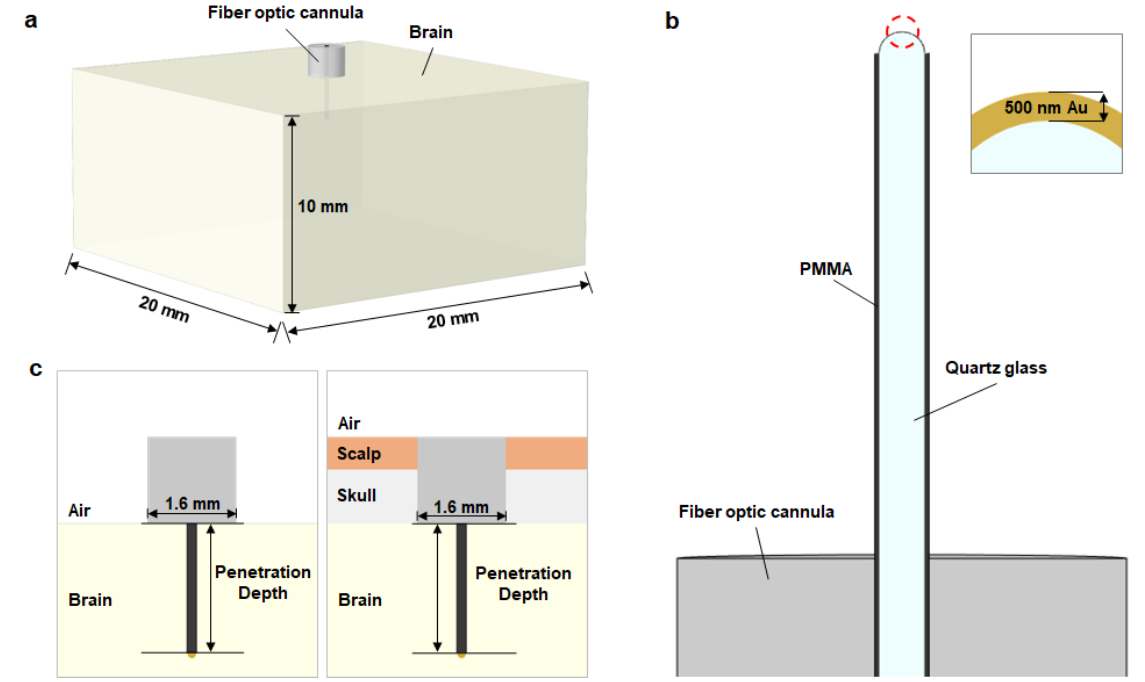
Figure 2. Computational model of the temperature analysis of the photothermal effect using TP optical fiber in vivo. ( a ) Schematic graphics of gold-nanorods-attached optical fiber in the brain for the finite-element analysis (FEA). ( b ) Cross- sectional view of the optical fiber and brain without and with the skull and scalp. ( c ) Model of gold-nanorods-attached optical fiber. Inset image shows the thickness of the gold nanofilm coated on the core tip of the optical fiber.